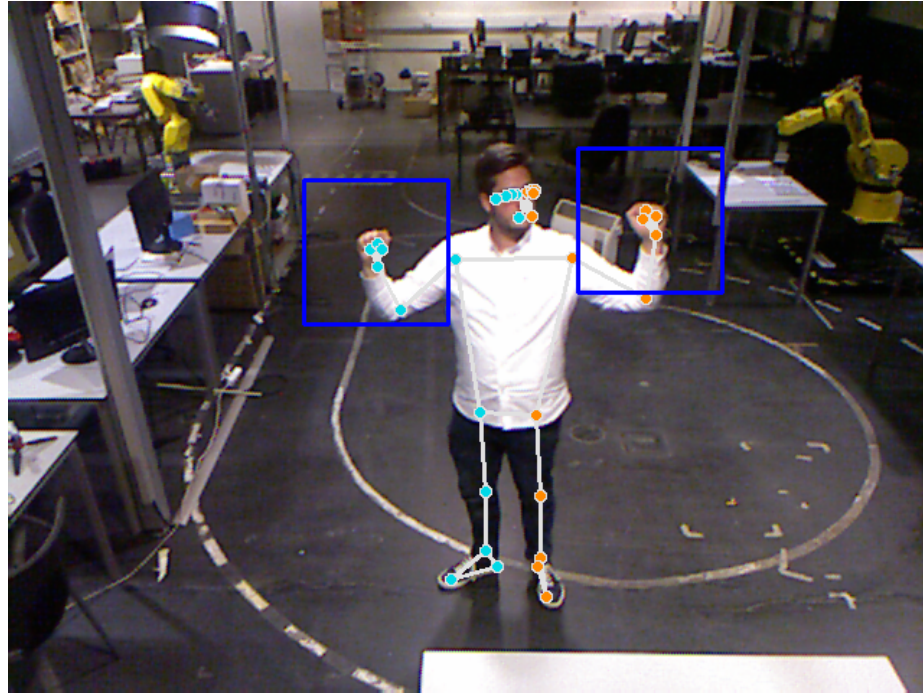
Figure 2. Example of user and hand gesture detection using human pose detection and tracking of the MediaPipe framework. The colored landmarks are generated by Mediapipe and the blue frames represent the region of interest for